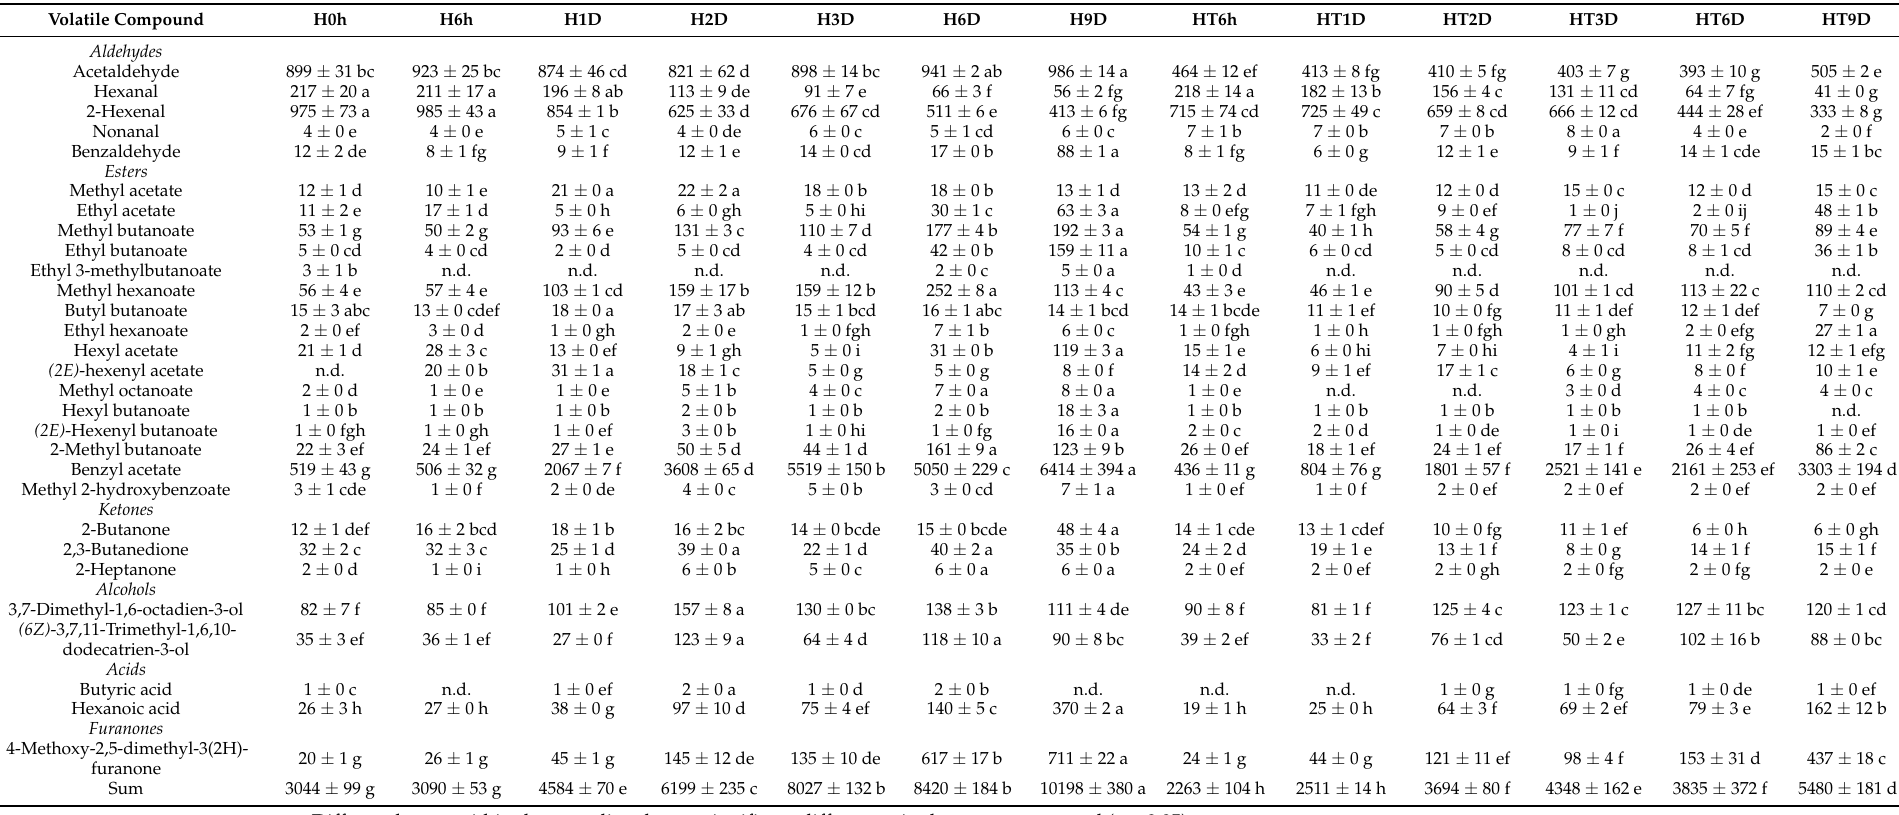
Table 2. Changes in the relative concentrations of volatile compounds in untreated (control) and CO 2 -treated half-red